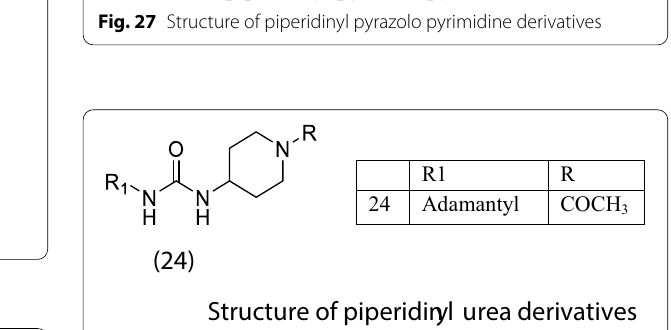
Fig. 28 Structure of piperidinyl urea derivatives